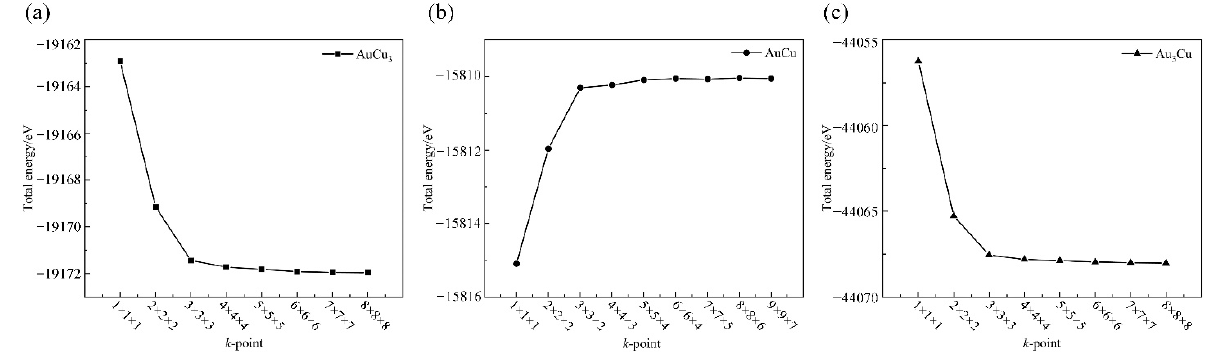
Figure A1. The relationship between k -point and total energy: ( a ) AuCu 3 , ( b ) AuCu, ( c ) Au 3 Cu.